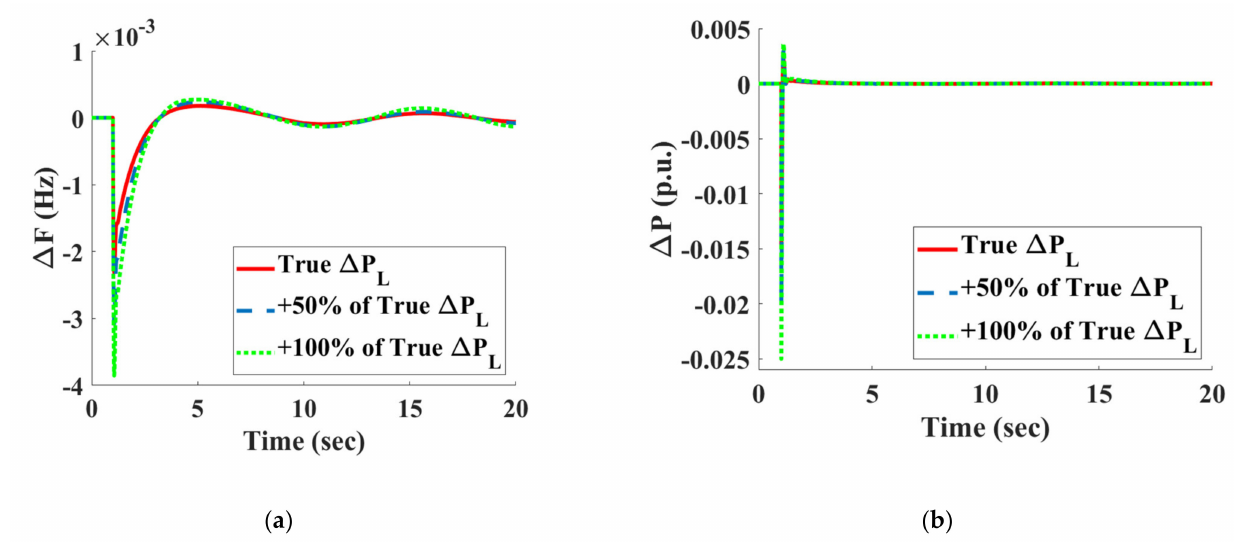
Figure 8. Sensitivity analysis of the HPSREG with the “PID-With-VI-FO-F-PID” configuration during +50% and +100% changes in load demand: ( a ) ∆ F ( Hz ) and ( b ) ∆ P ( p . u . ) . Table 5. Comparative study of dynamic responses offered by the HPSREG under parameter variation of K P . Parameter Variation